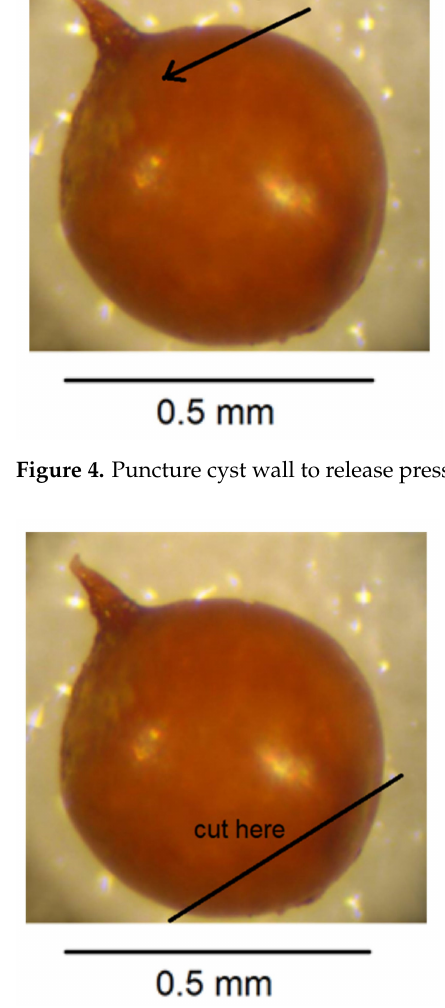
Figure 5. Cut across base of cyst to retain vulval and anal region.